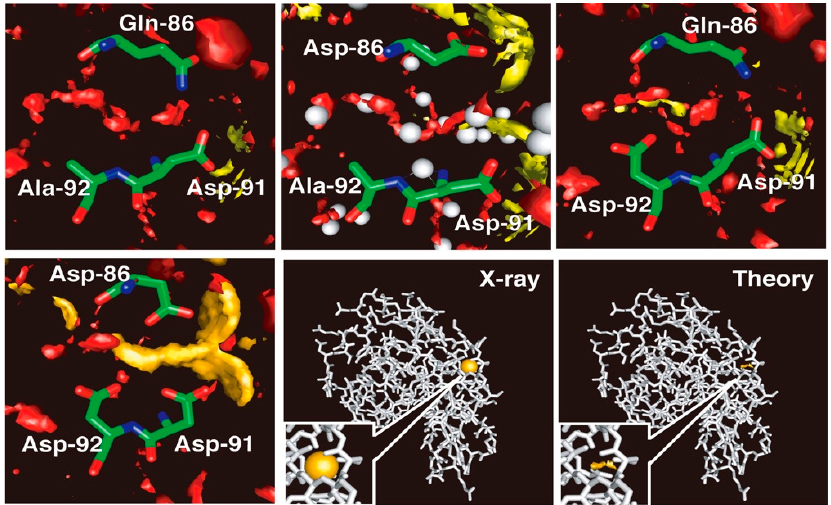
Figure 6. The 3D-distribution of ions in lysozyme. Upper left, wild type; upper middle, Q86D mutant; upper right, A92D mutant. lower left, Q86D /A92D mutant. The theoretical result for the Q86D /A92D mutant is compared with the result of the X-ray crystallography in the lower right two panels: The binding sites are closed up in the insets of the two panels. (The figure is reprinted from Refs. [60,61]. Copyright (2006) and (2007) American Chemical Society.)